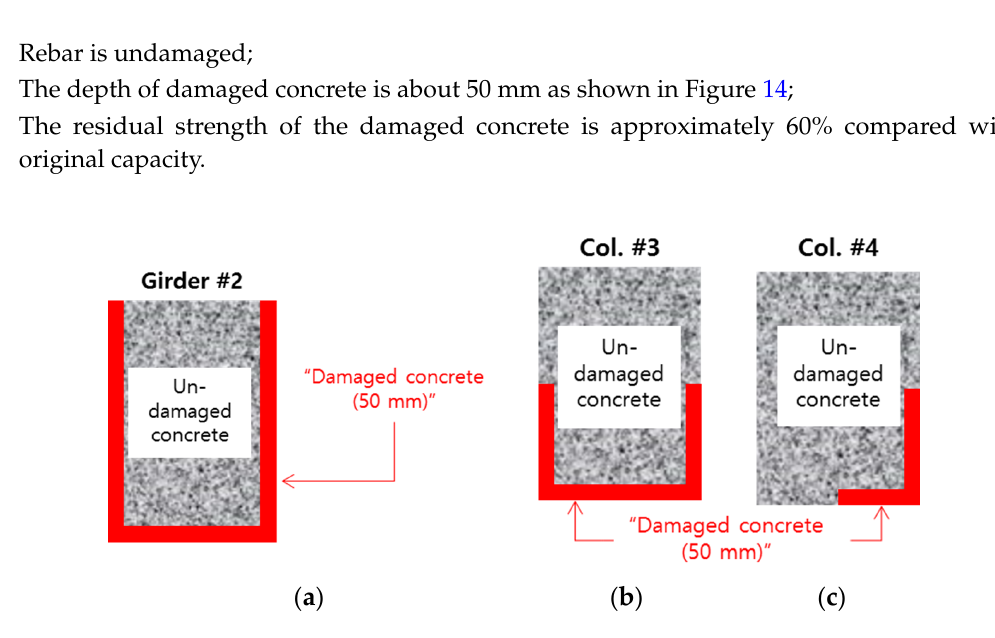
Figure 14. Assumed depth of damaged concrete for target elements: ( a ) Girder #2, ( b ) Column #3 and ( c ) Column